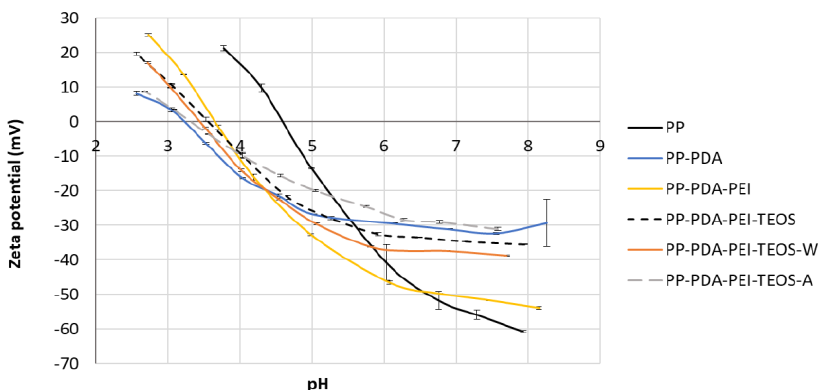
Figure 7. Zeta potential of (un)modified PP films after 7 days of incubation in SBF at different pH.